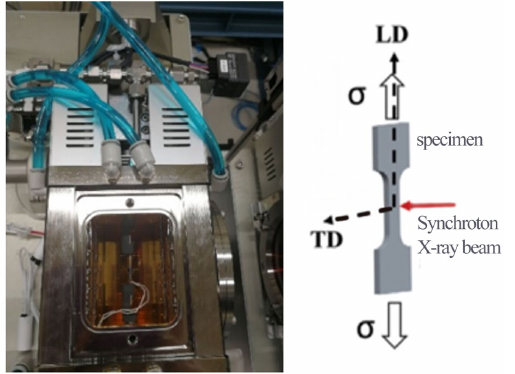
Figure 2. Synchrotron radiation in situ stretching device.